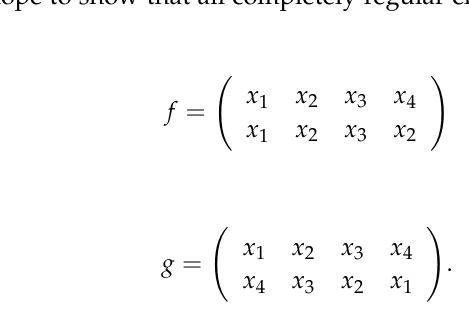
Figure 1 Graph S